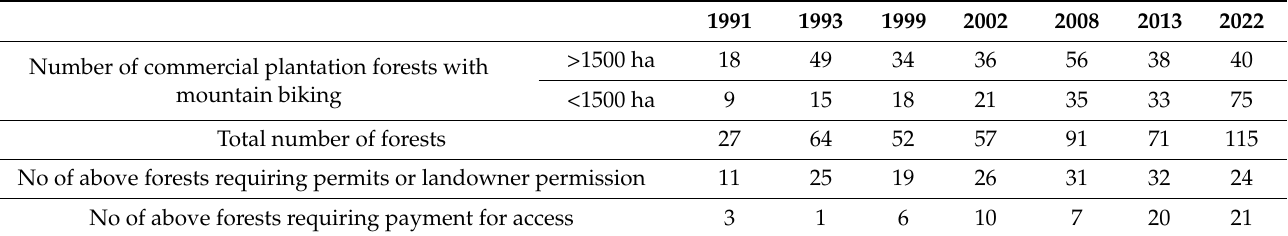
Table 2. Number of planted forest areas being accessed for mountain biking activity,